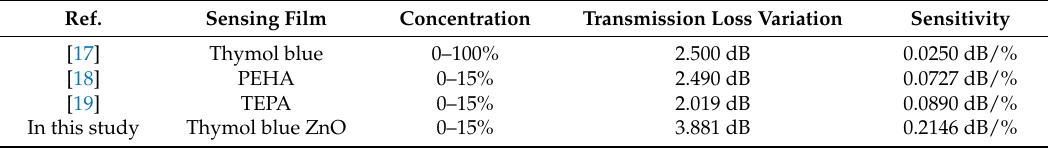
Table 2. Comparison with different sensors used to measure CO 2